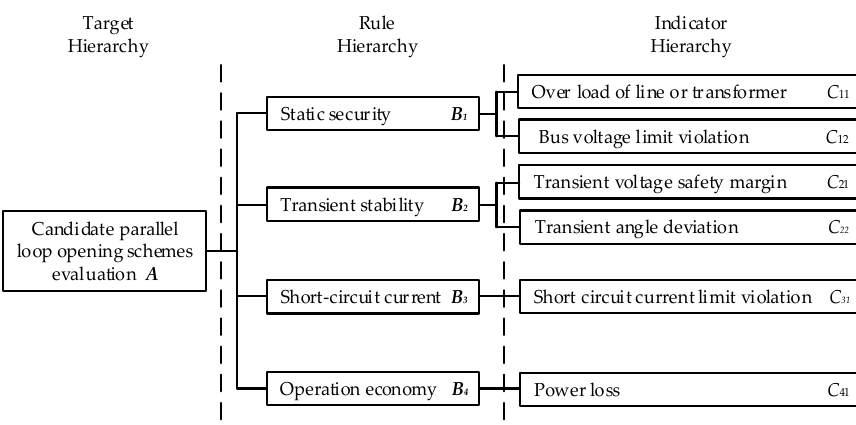
Figure 2. Comprehensive evaluation model for candidate opening schemes.